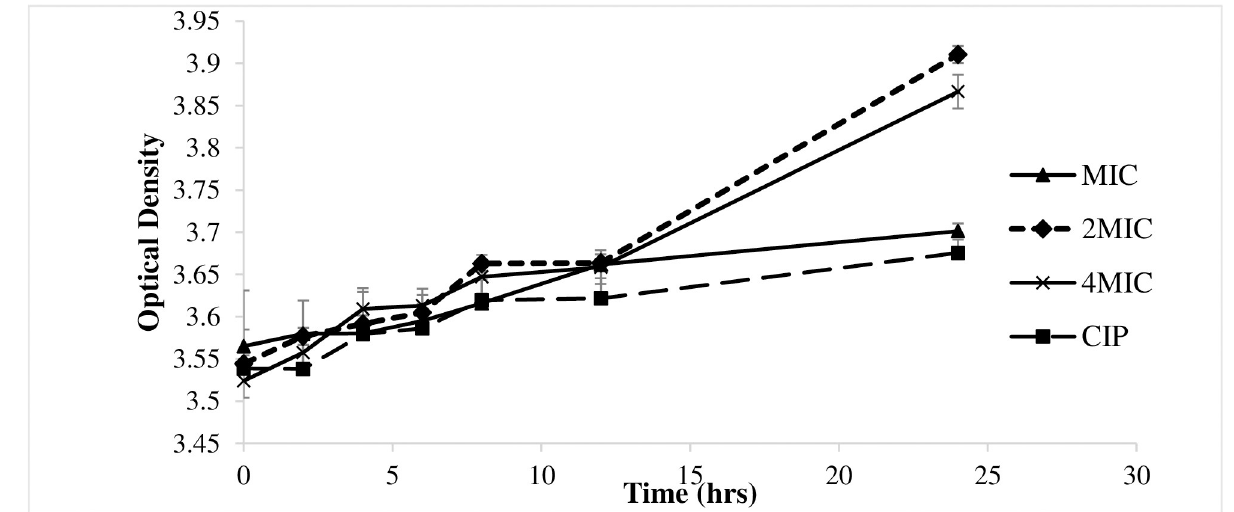
Fig 2. Effect of the methanolic root extract of G . kola on nucleotide leakage. CIP: Ciprofloxacin; ST: Salmonella typhi .